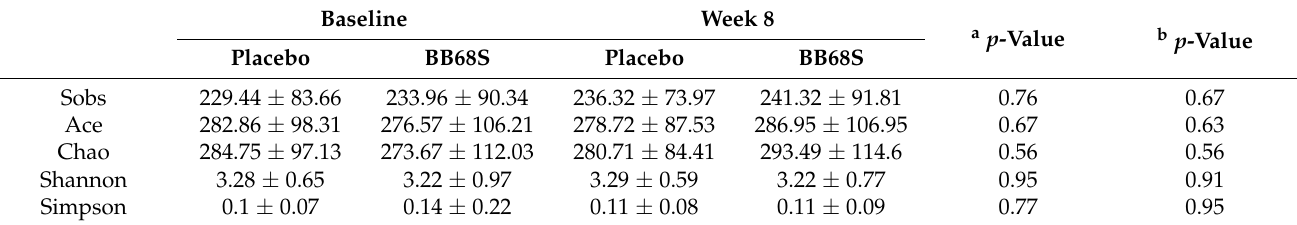
Table 3. The effects of BB68S on the α-diversity.